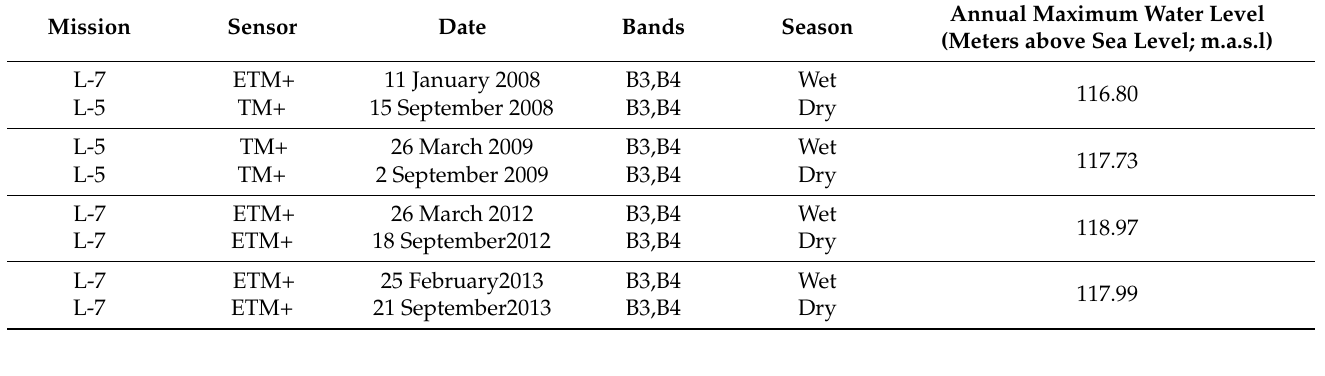
Table 1. LANDSAT data and the annual maximum water level during the observed period.